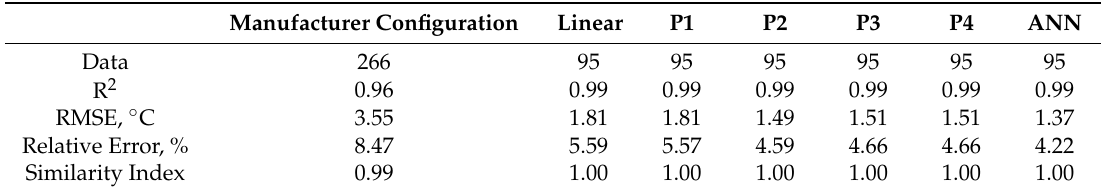
Table 2. Main statistic indices of the manufacturer configuration, linear model, polynomial models (P1–P4), and the artificial neural network